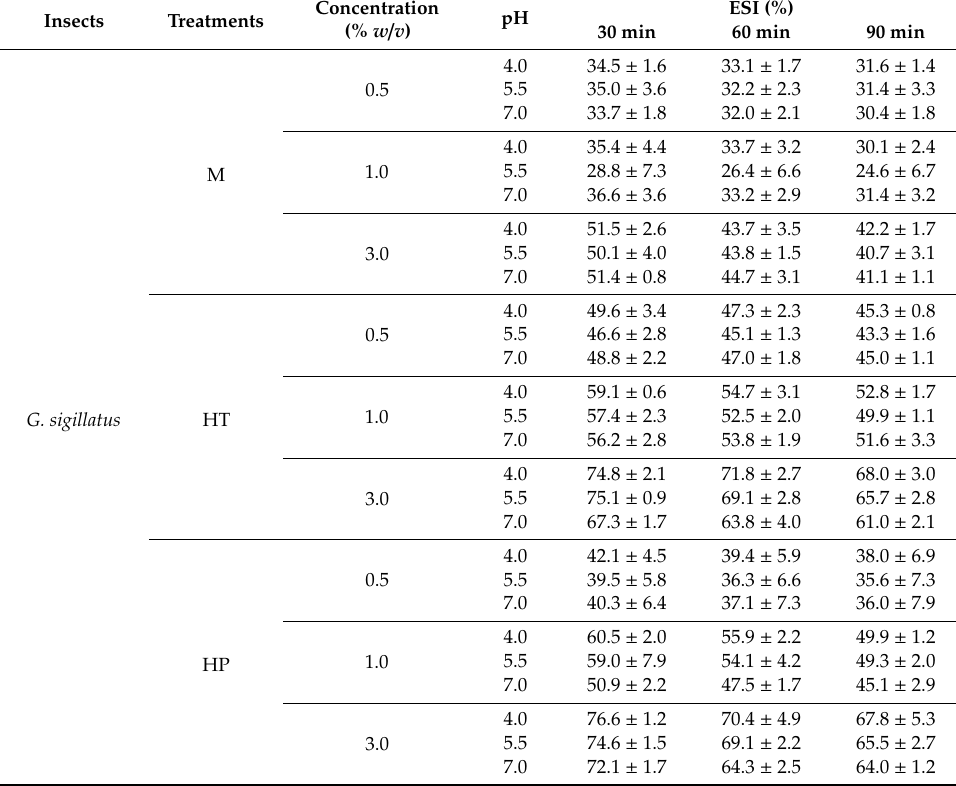
Table 5. ESI of cricket and mealworm meals and their hydrolysates (control and generated from pressure-treated insect meals) according to the aqueous phase concentration and